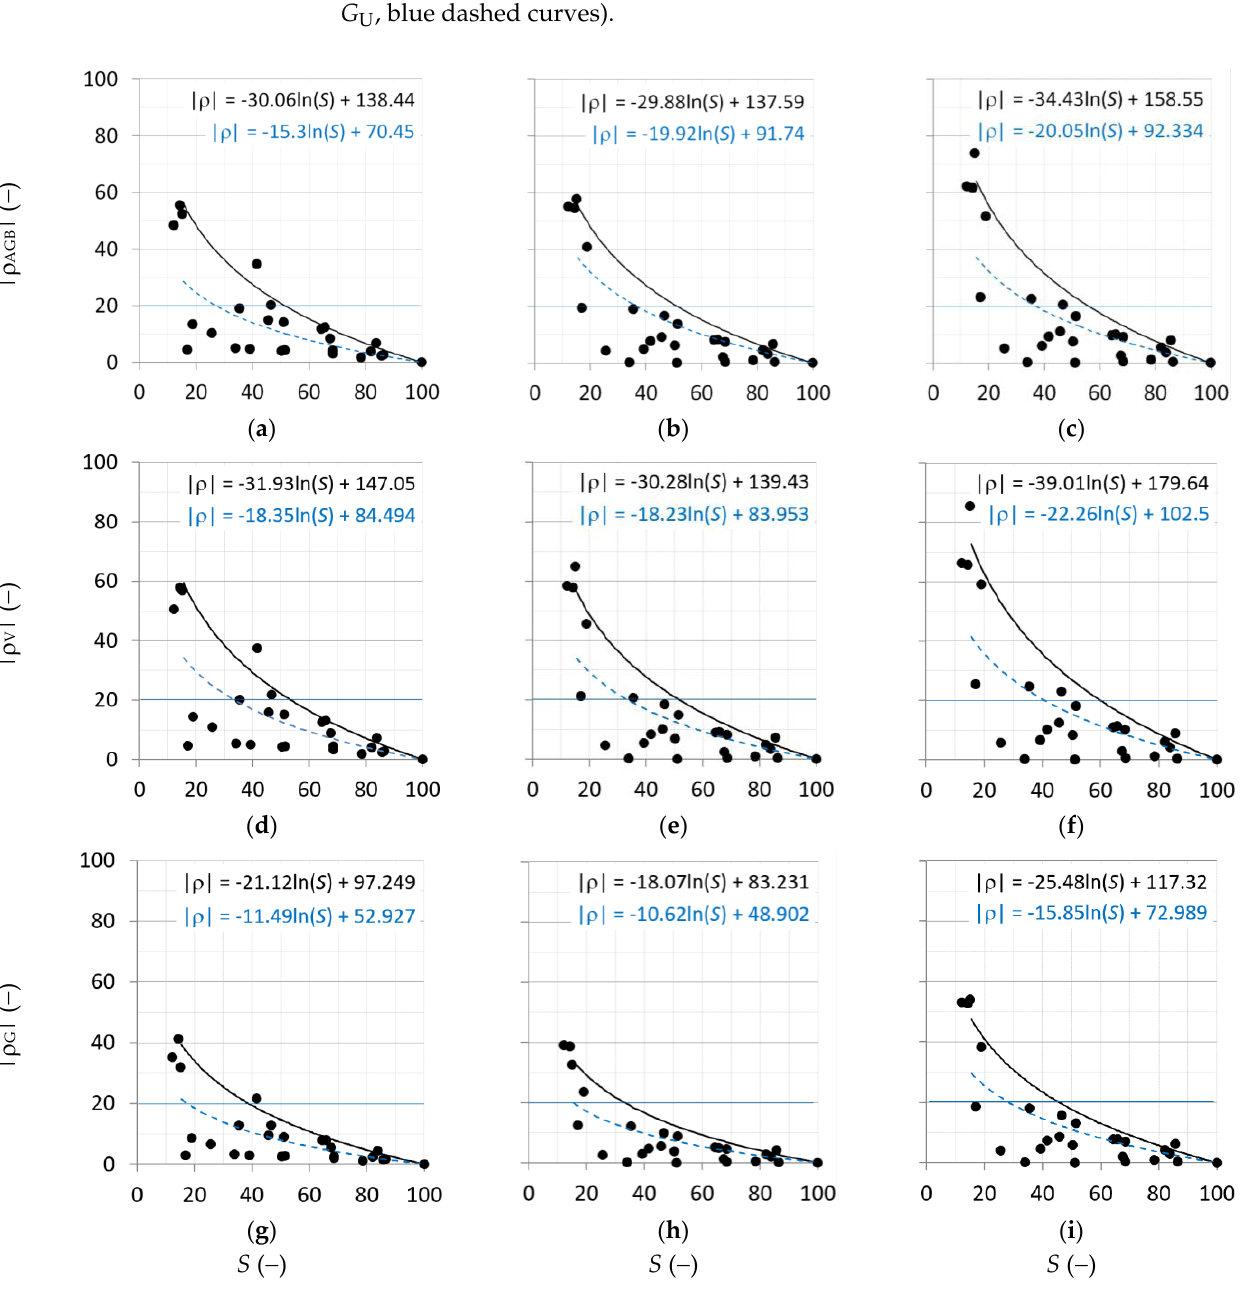
Figure 13. The absolute value of the relative error, | ρ |, of the structural attribute by varying the percentile of the sampling area, S . Logarithmic trend lines refer to the 99th percentile (black continuous line) and the average (dashed blue line). The values | ρ | are estimated from the H CHM by employing the exponential trend curve, the lower, and the upper interpolation curves. In the upper panels, ( a ) AGB , ( b ) AGB U , and ( c ) AGB L (upper panels); in the intermediate panels, ( d ) V , ( e ) V U , and ( f ) V L ; in the lower panels, ( g ) G , ( h ) G U , and ( i ) G L . A blue horizontal line indicates an acceptable error of